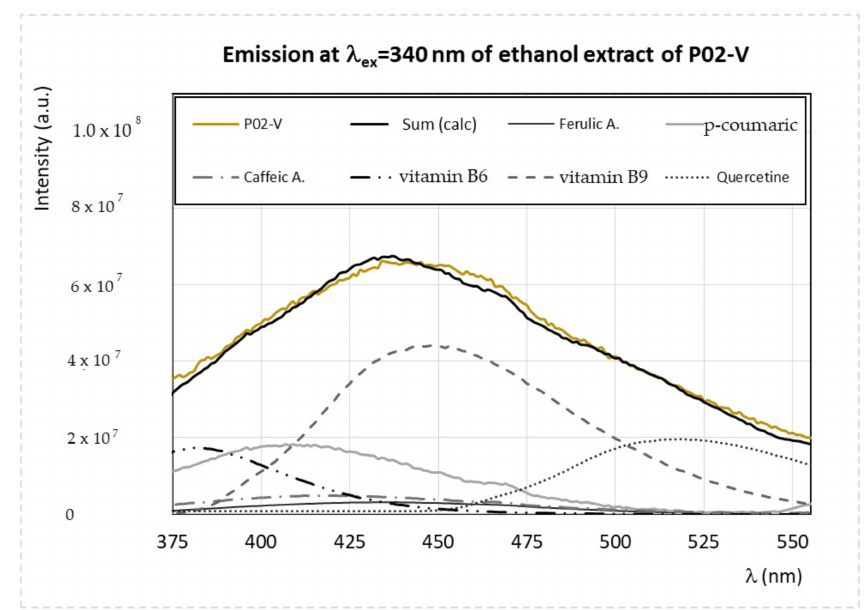
Figure 5. Experimental and calculated FFF emission spectra of the ethanol extracts obtained from the samples P02-V, prepared as described in the main text, obtained by exciting the sample at λ ex = 340 nm. The calculated spectrum, indicated as Sum (calc), is obtained as the sum of di ff erent components: